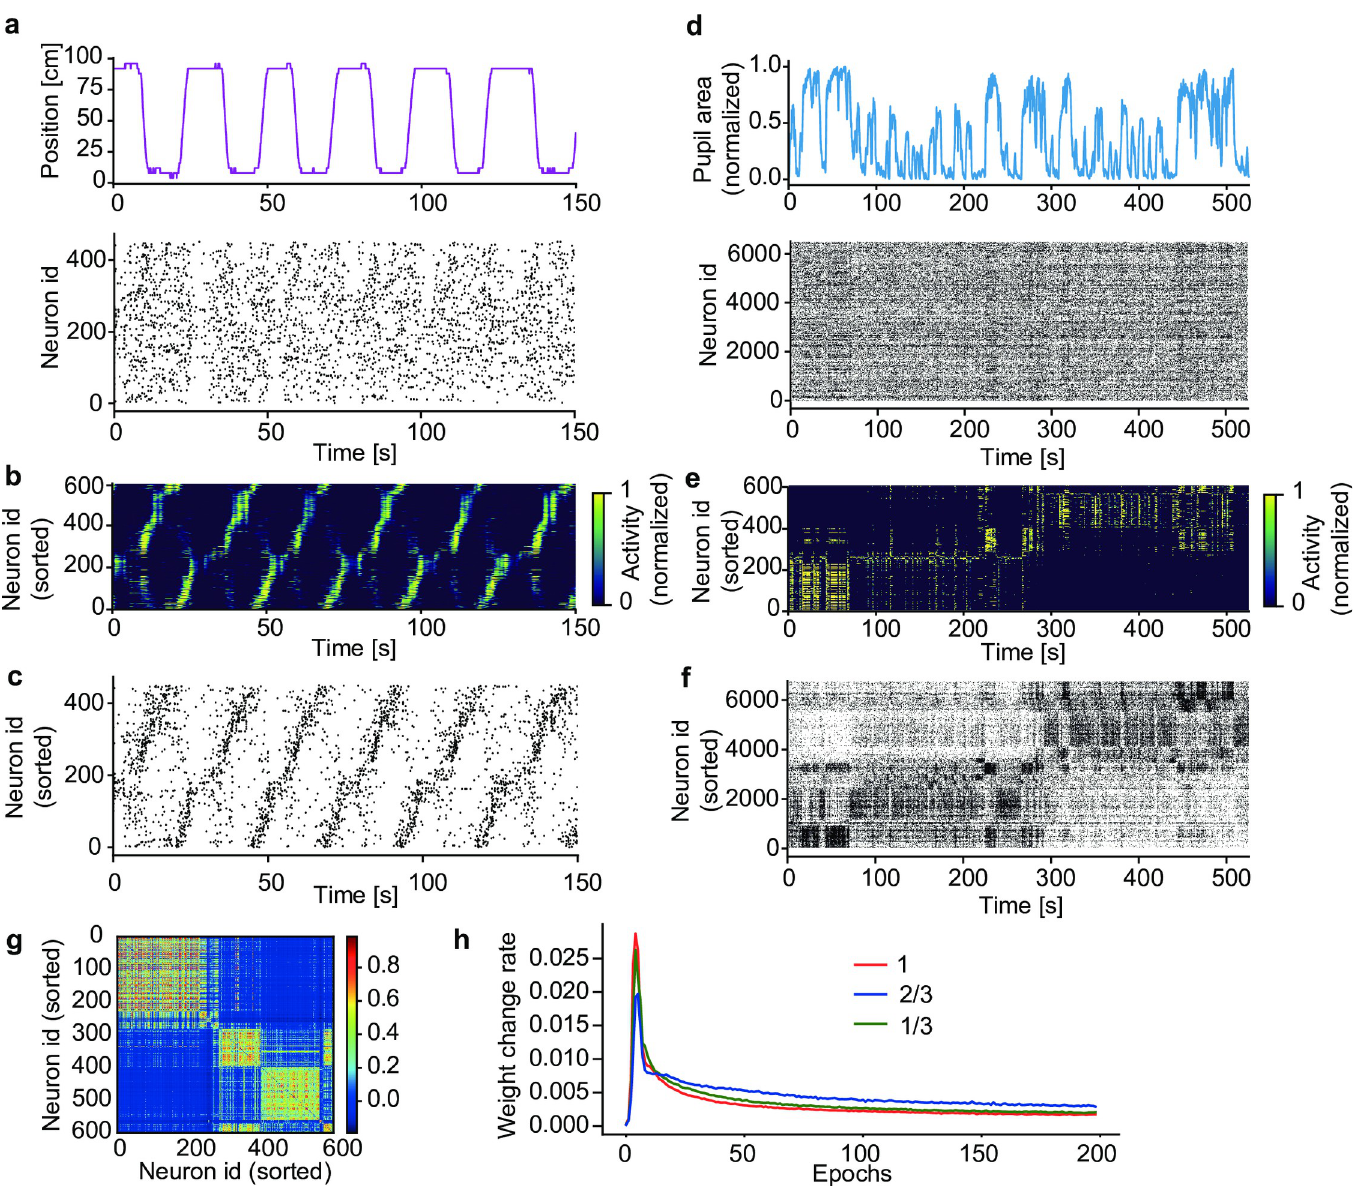
Fig 6. Detecting salient activity patterns in calcium imaging data. (a) The positions of a mouse (top) on a linear track and calcium imaging data of activity of 452 hippocampal CA1 neurons (bottom) were obtained from previously recorded data [23]. (b) The learned activities of model neurons were sorted according to their onset response times. (c) Each CA1 neuron was associated with a model neuron having the highest mutual correlation with the CA1 neuron. Then, the CA1 neurons were sorted according to the serial order of model neurons shown in (b). (d) The time course of normalized pupil area (top) and simultaneously recorded activities of 6,532 visual cortical neurons (bottom) were calculated from previously recorded data [24,25].(e) Activity of a trained network model was sorted according to their onset response times (Methods). (f) Activities of the cortical neurons were sorted as in (c). (g) Correlation matrix of the population of network neurons is shown. (h) Learning curves over 200 epochs for various size of input neurons are shown. Red, blue and green traces show learning curves with the number of input neurons 1, 2/3, 1/3 times smaller than original 6,532 neurons. The weight change rate was calculated as the ratio of the sum of the absolute values of synaptic changes to the sum of the absolute values of all